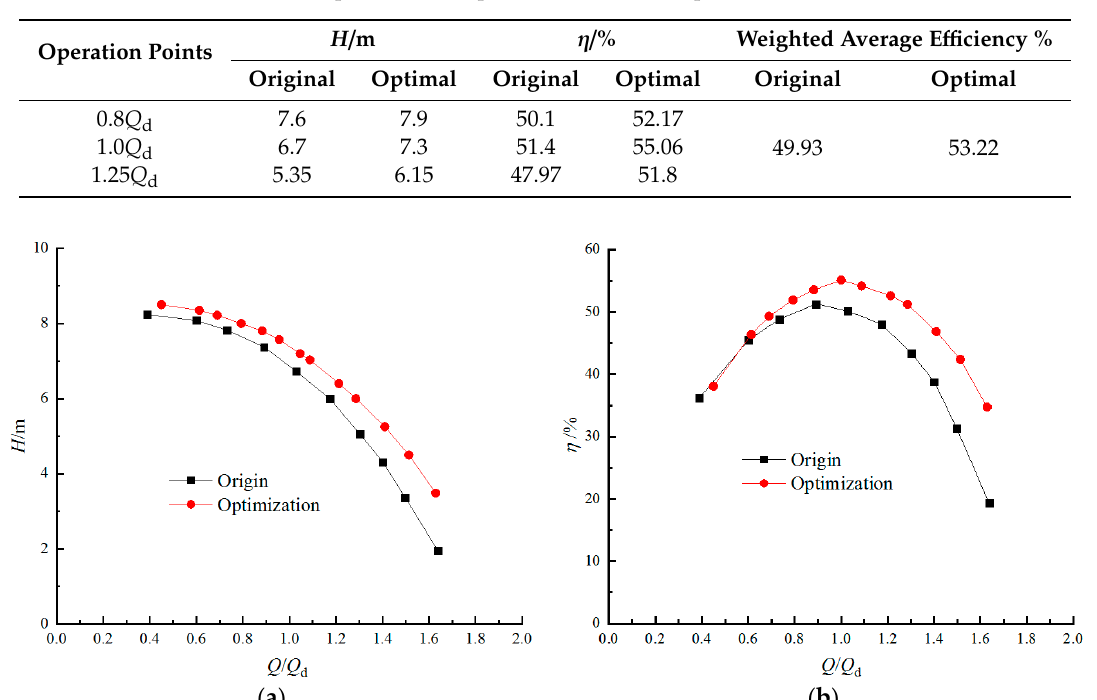
Figure 11. Comparison of external characteristic curves between origin and optimization scheme: ( a ) Head; ( b ) Efficiency.